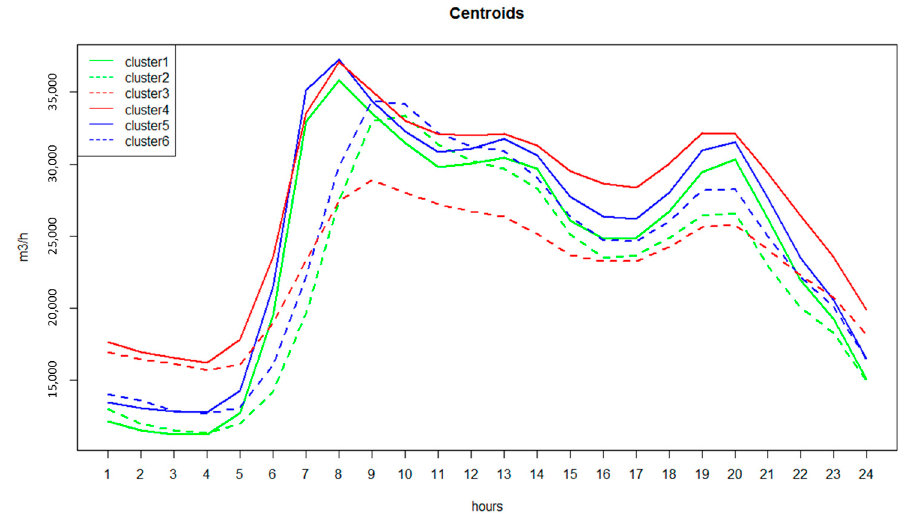
Figure 6. The k = 6 typical water demand patterns identified through the two-level clustering procedure. The cluster assignment is the same as the previous Figure 1.